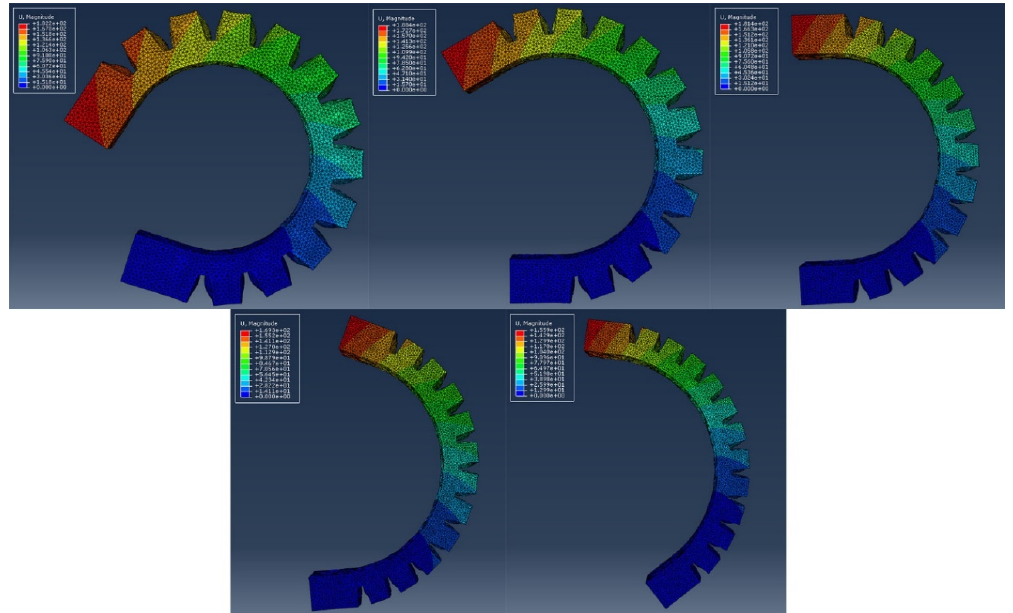
Figure 3. The maximum displacement of the soft landing region when encountering different